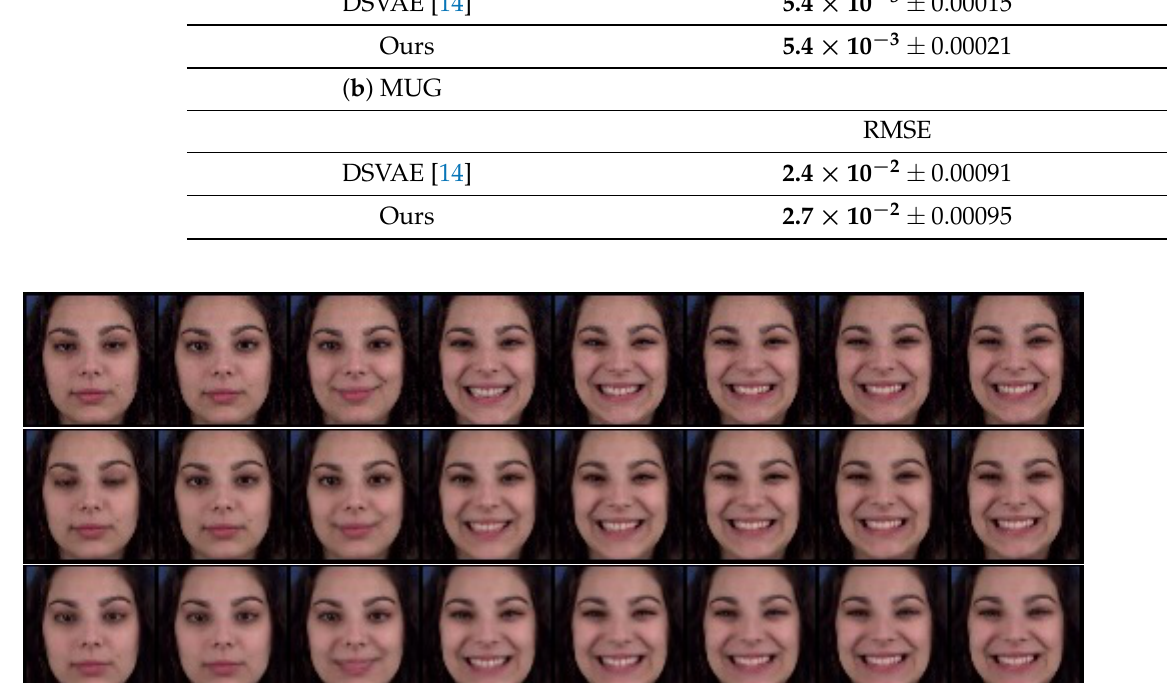
Figure 6. Example of reconstruction on the MUG dataset. The top, middle, and bottom rows denote the input video and the results using DSVAE and the proposed method,